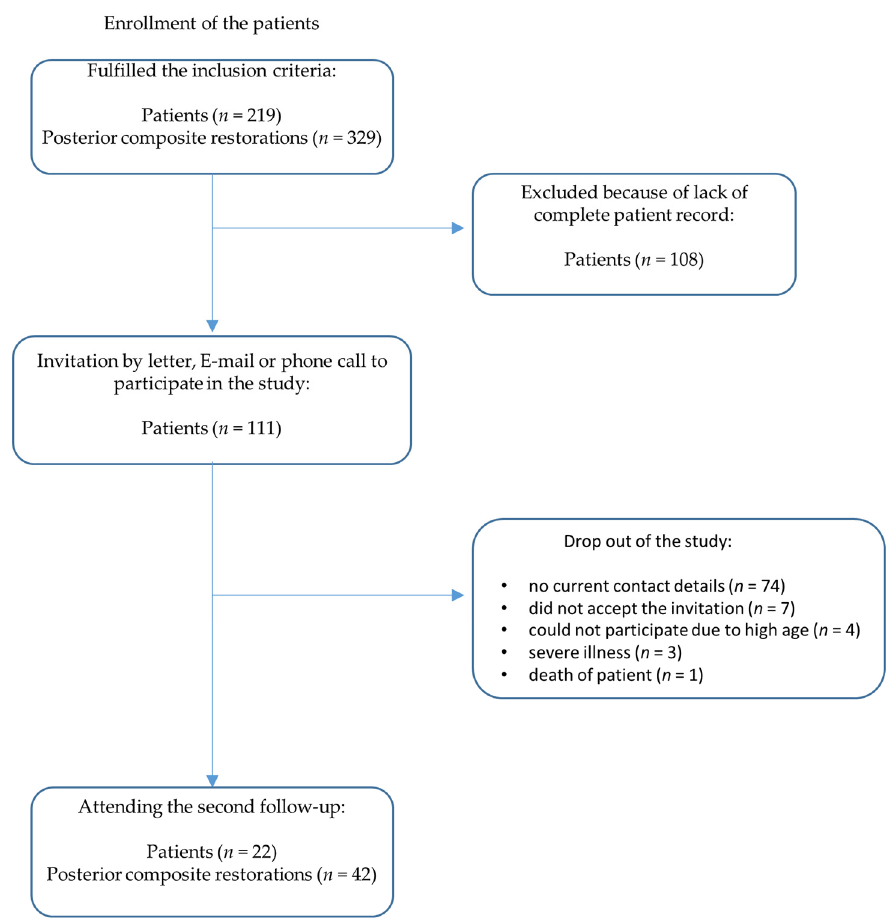
Figure 1. Flow diagram: enrollment of the patients.